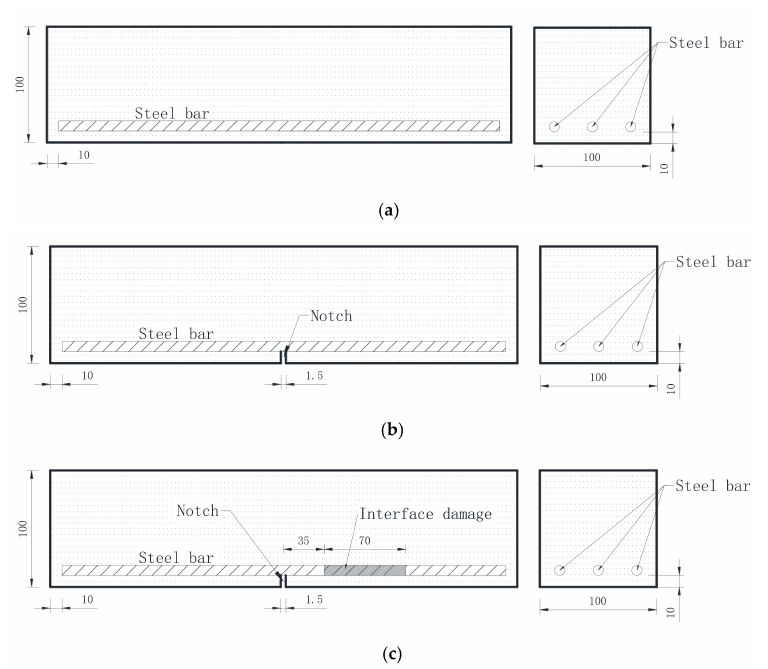
Figure 5. Front and side view of test beam (cm): ( a ) RPC and BFRPC; ( b ) RPC-N and BFRPC-N; ( c ) RPC-N-ID and